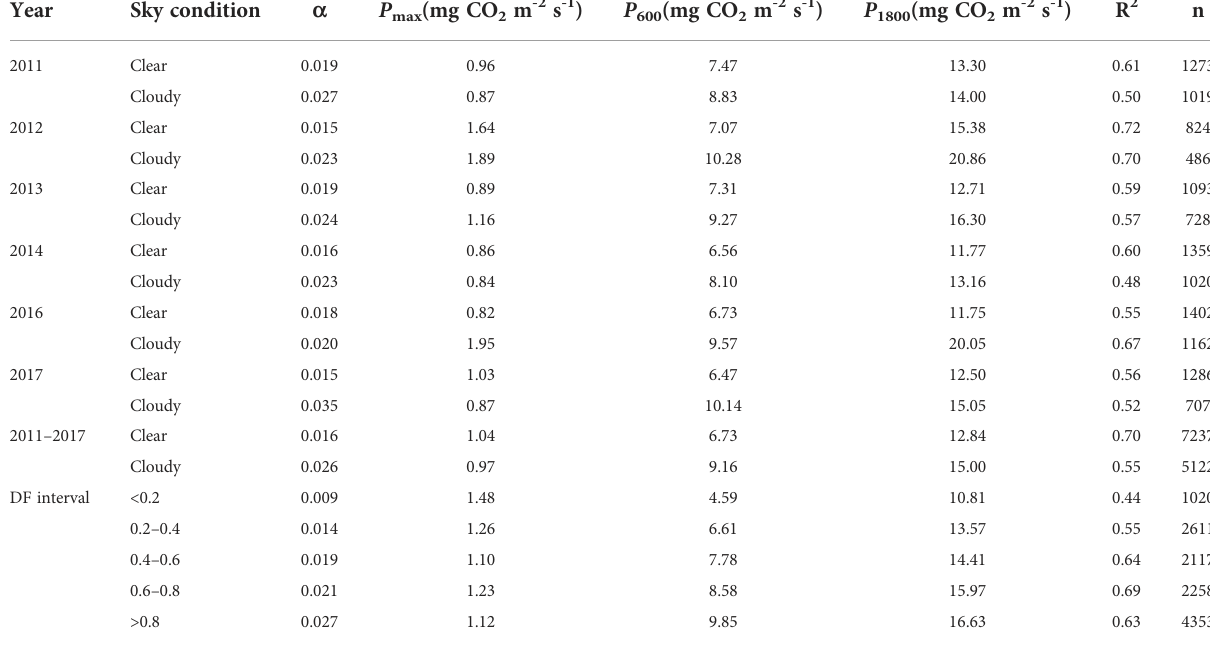
All regressions are signi fi cant at the level of p <0.05. DFisdiffusefraction, a isecosystemapparentquantumyield, P max isthemaximumecosystemphotosyntheticcapacity, P 1800 isGPPathighPAR(1800μmolm − 2 s − 1 )and P 600 isGPPatlow PAR (600 μmol m − 2 s − 1